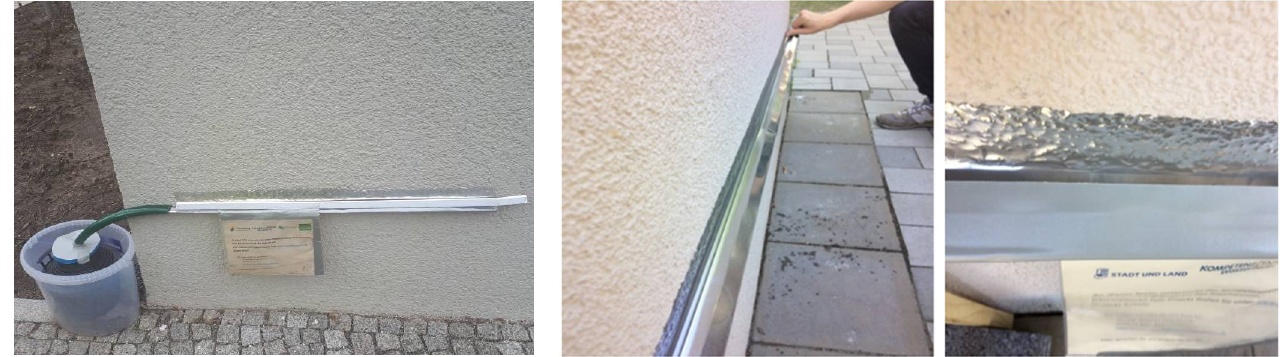
Figure A2. Installation of a gutter to capture façade runoff.